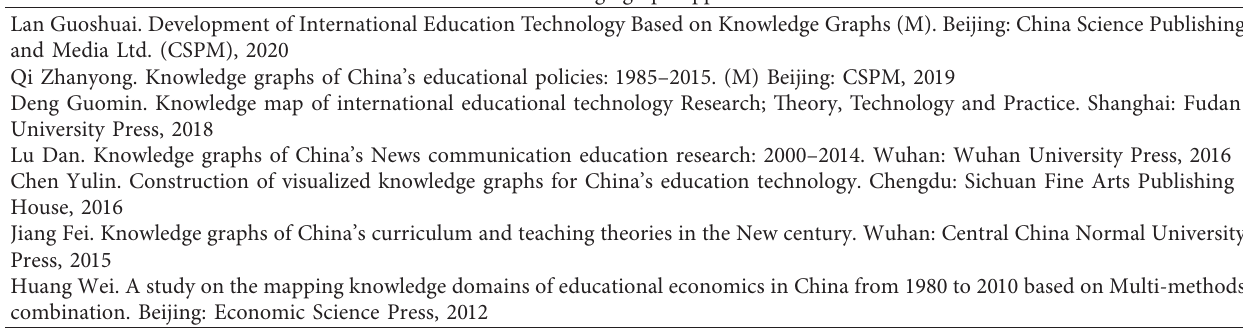
Table 2: Books on knowledge graph applications in